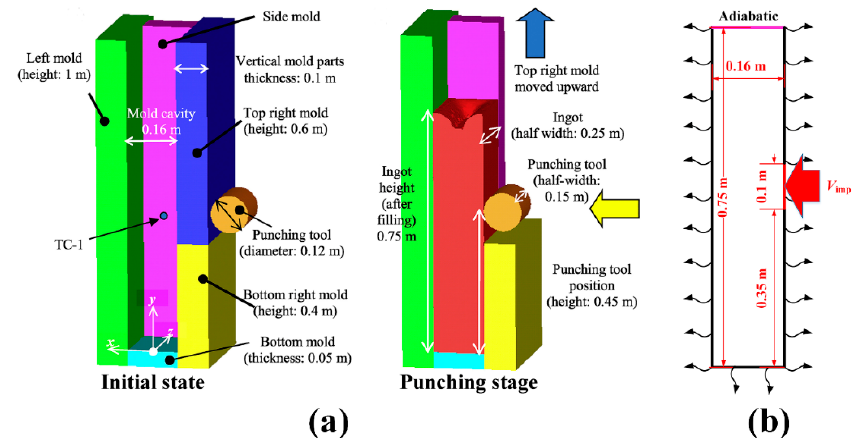
Figure 2. Schematic [17] ( a ) and 2D computation domain ( b ) of the 450 kg steel ingot punching test. The configuration shown in ( a ) is half of the setup. A thermocouple (TC-1) is placed at coordinates (0, 0.43, 0.06).